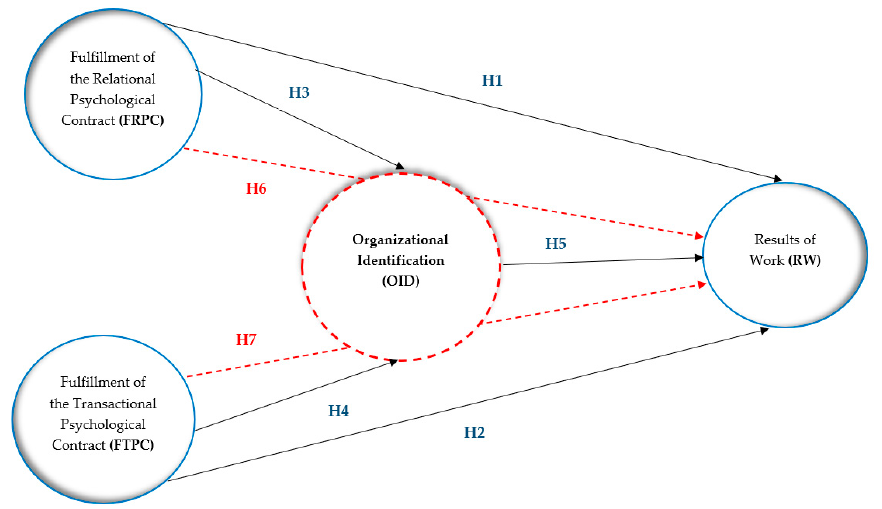
Figure 1. Research model of relationships between the fulfilment of the relational and transactional psychological contract and HR professionals’ work results and the mediating effect of organisational identification .